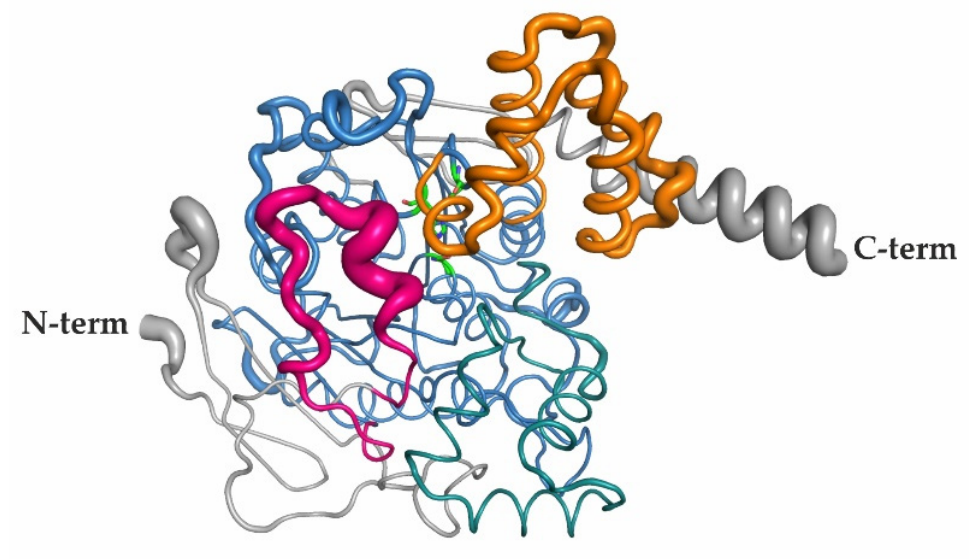
Figure 5. Overall structure of mCes2c in tube representation. The flexibility of individual residues indicated based on B-factor values. The cap residues (teal) have an average B-factor of 25.2 Å 2 , whereas the lid region (N100-L116, indicated in pink) exerts high flexibility resulting in an average B-factor of 64.5 Å 2 . The α / β -hydrolase core is shown in blue, RD in orange, catalytic triad residues S230, E347, and H459 are shown as green sticks.